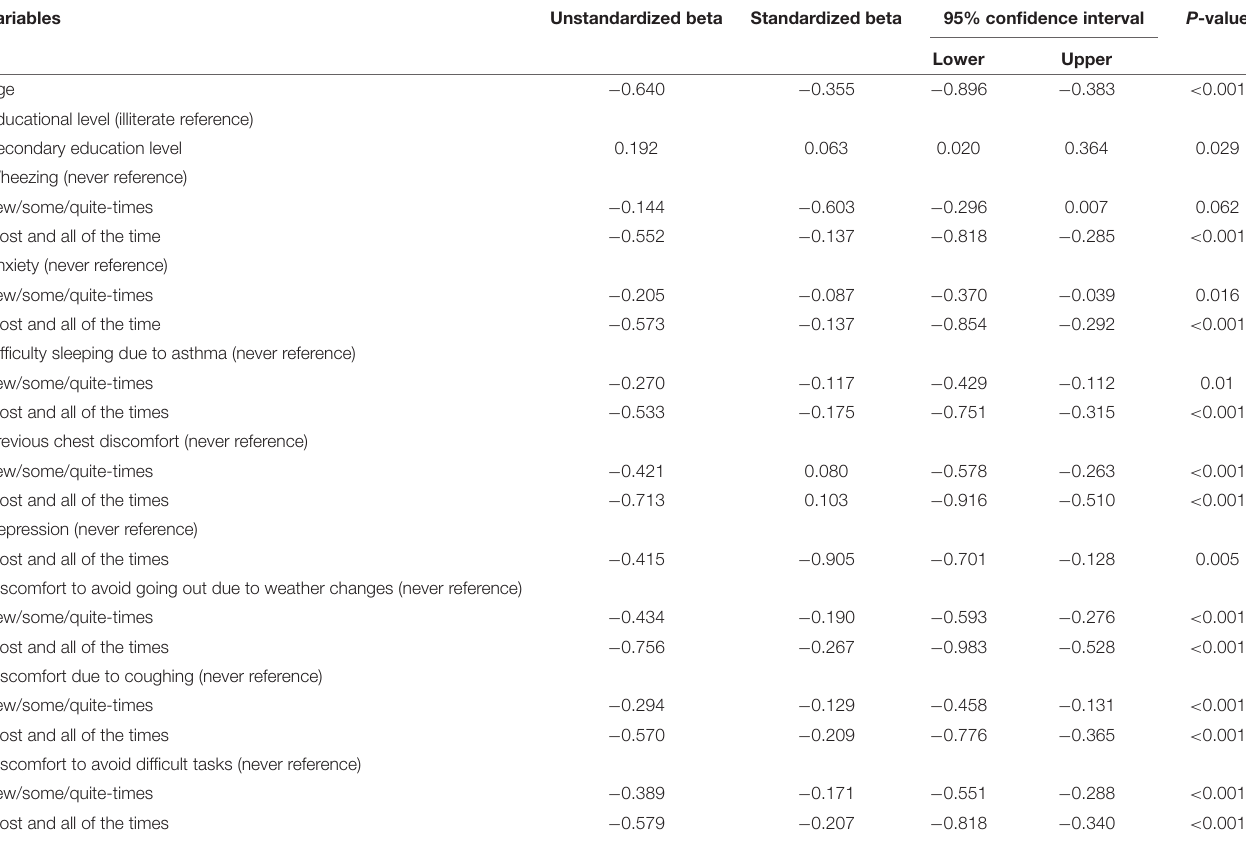
TABLE 3 | Linear regression taking quality of life score as the dependent variable and wheezing, anxiety, insomnia, chest discomfort, depression, asthma knowledge score, and monthly income as the independent